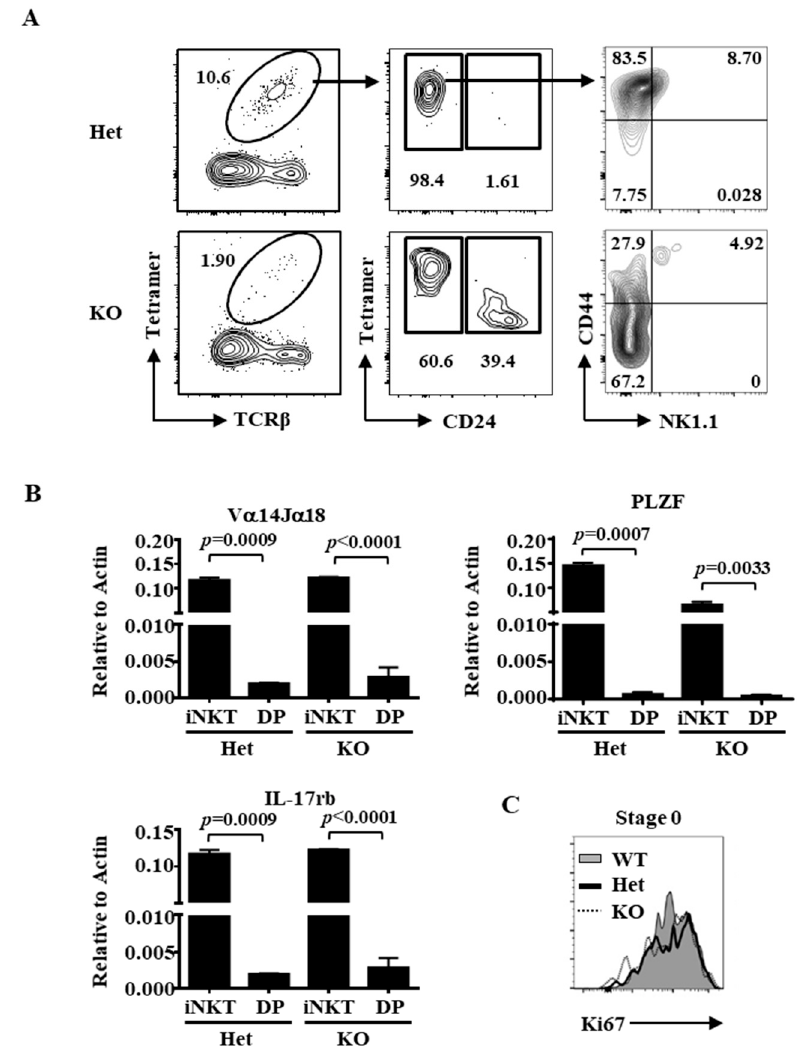
Figure 2. Enrichment of iNKT cells by CD1d-tetramers. ( A ) CD1d-tetramer-enriched iNKT cells from the indicated genotype were identified with TCR and loaded CD1d tetramer (left panels), subsequently separated into stage 0 and stage 1–3 based on the level of CD24, NK1.1, and CD44 (right panels). ( B ) Enriched iNKT cells from the indicated genotype were subjected to quantitative PCR using primers corresponding to the transcripts of V α 14 J α 18 TCR, PLZF, and IL-17rb. ( C ) Ki67 staining of stage 0 iNKT cells is shown.